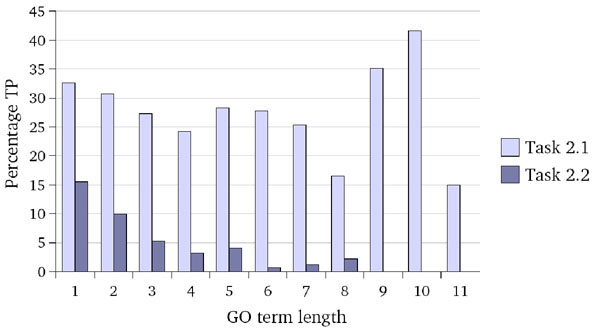
Task 2.1 True positive predictions compared to GO term length. This plot shows the association between the number of true positives (TP), meaning predictions where the GO term and the corresponding protein were correctly predicted (evaluated as 'high') and the length of GO terms in task 2.1. The length of GO terms was measured by the number of words which form the terms, after splitting at spaces, and certain special characters (e.g. '-', '/' and ',').